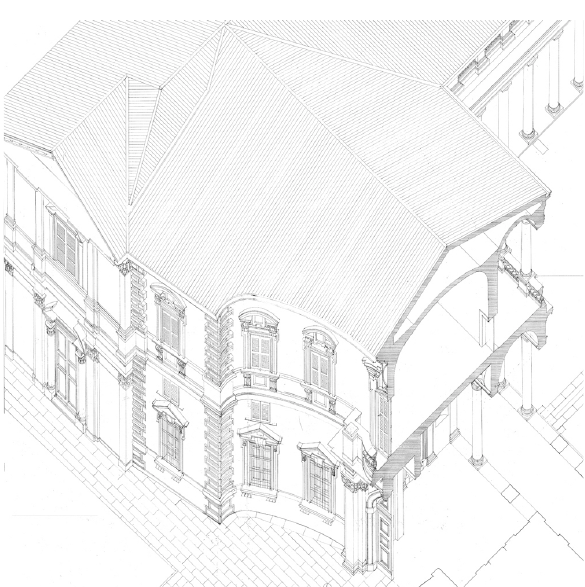
Figure 8 – Isometric Cross section of the Senate Palace in (De Masi, A.)